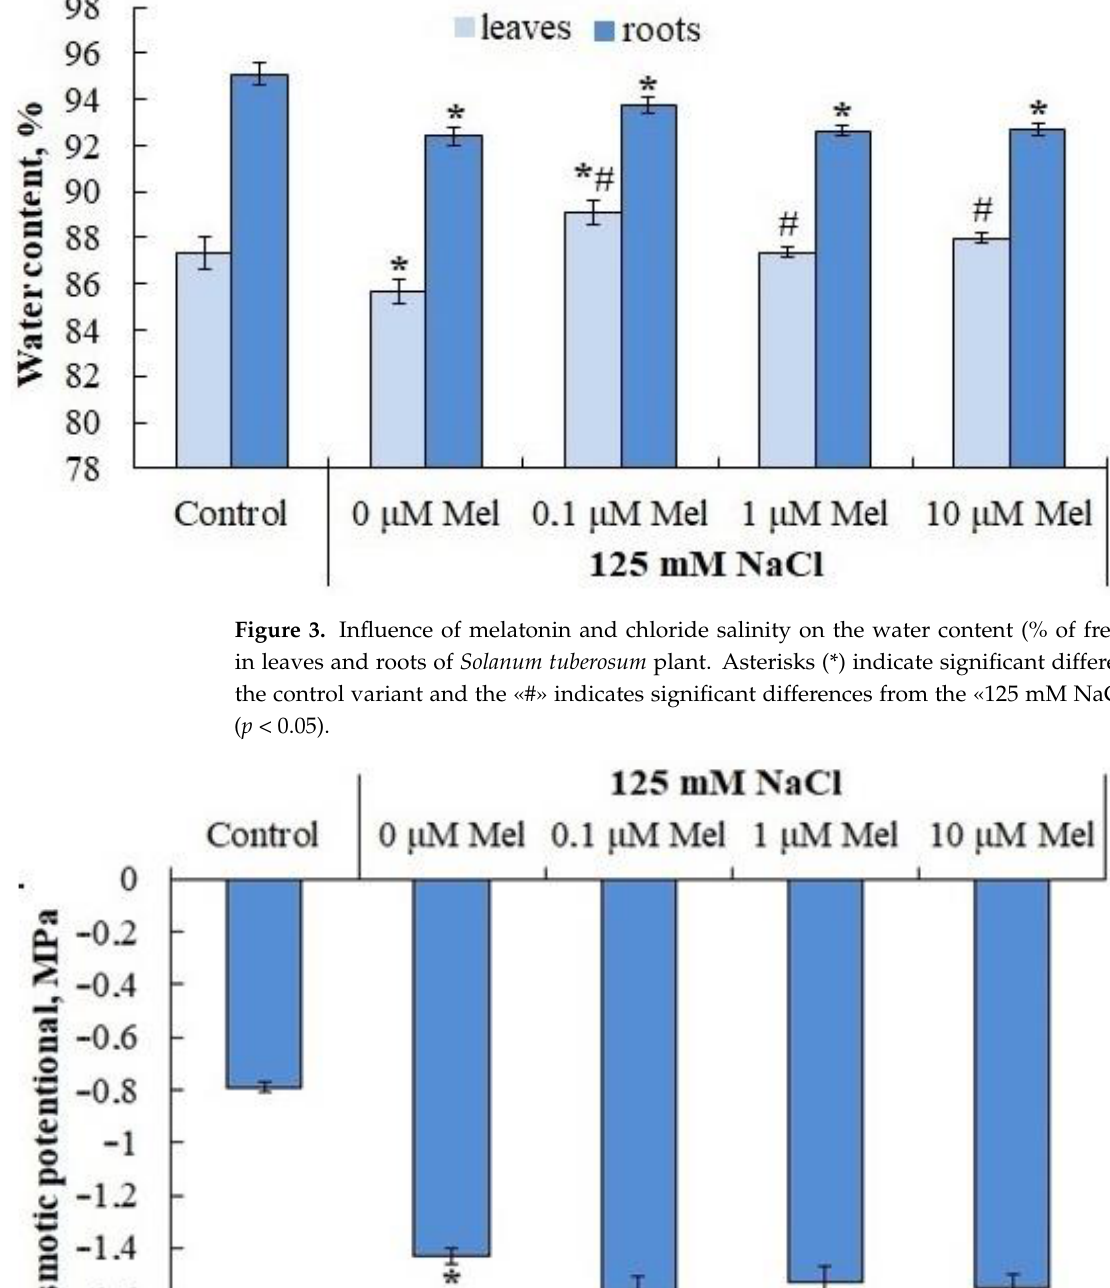
Figure 4. Influence of melatonin and chloride salinity on the value of the osmotic potential of the cellular exudate of Solanum tuberosum leaves. Asterisks (*) indicate significant differences from the control variant ( p < 0.05).